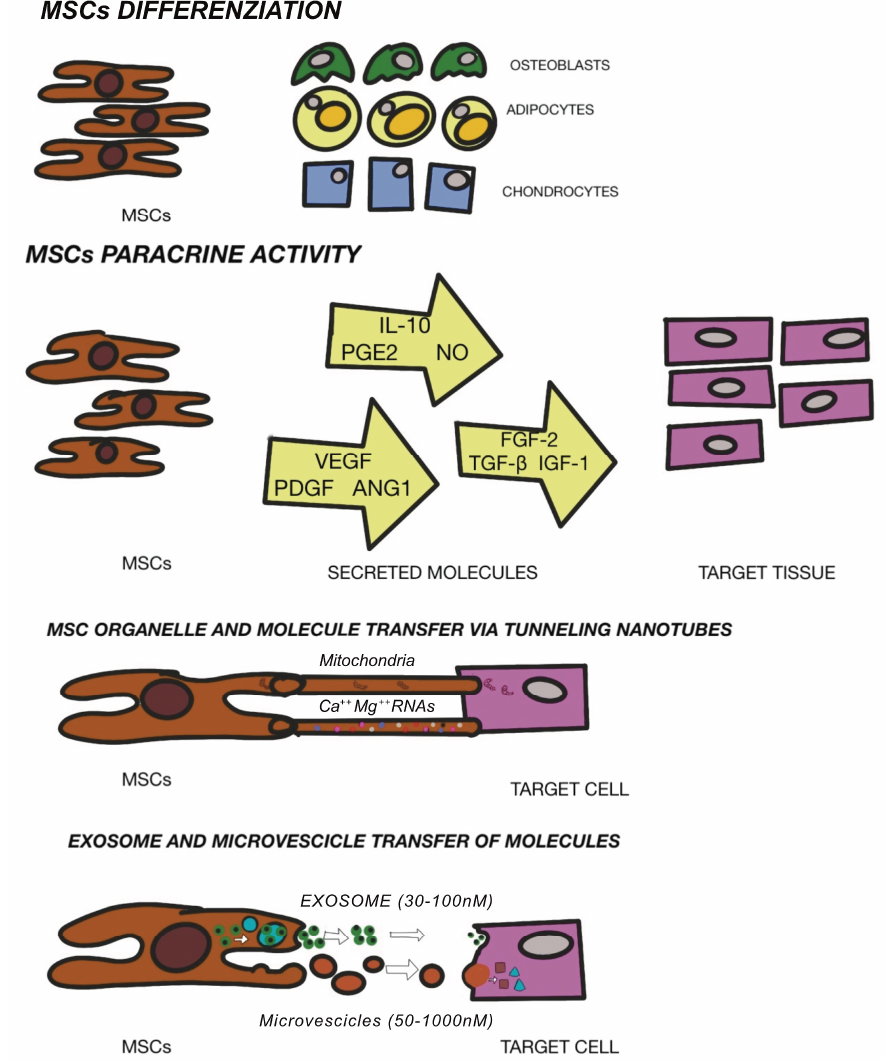
Figure 3. Mechanism of MSC mediated repair. Modified from Fellows CR et al. Front Genet. 2016. 3.3. Intra-articular Application of Autologous Microfragmented Adipose Tissue with Stromal Vascular Fraction Adipose stem cells (ASCs) are able to renew themselves and create multiple lineages [74]; besides, they can readily and rapidly expand in vitro, will not age easily and provoke fewer morbidities in patients [75]. ASCs have also displayed significant potential to prop- agate and differentiate into mesoderm-like tissue in relation to bone marrow derived- MSCs or other sources [76]. Importantly, ASCs are easily isolated and particularly acces- sible from subcutaneous adipose tissue [77–79]. ASCs have also shown efficient chondro- genic differentiation during in vitro expansion under adequate conditions [80]. In any case, physical and mechanical factors are required to perform an adequate formation of the cartilage tissue in vivo such as mechanical stimuli or a particular texture of the scaf- folds [81,82]. The clinical use of ASCs is strictly regulated, because these products are con- sidered “drugs” and therefore particularly restricted in clinical practice in Europe and the